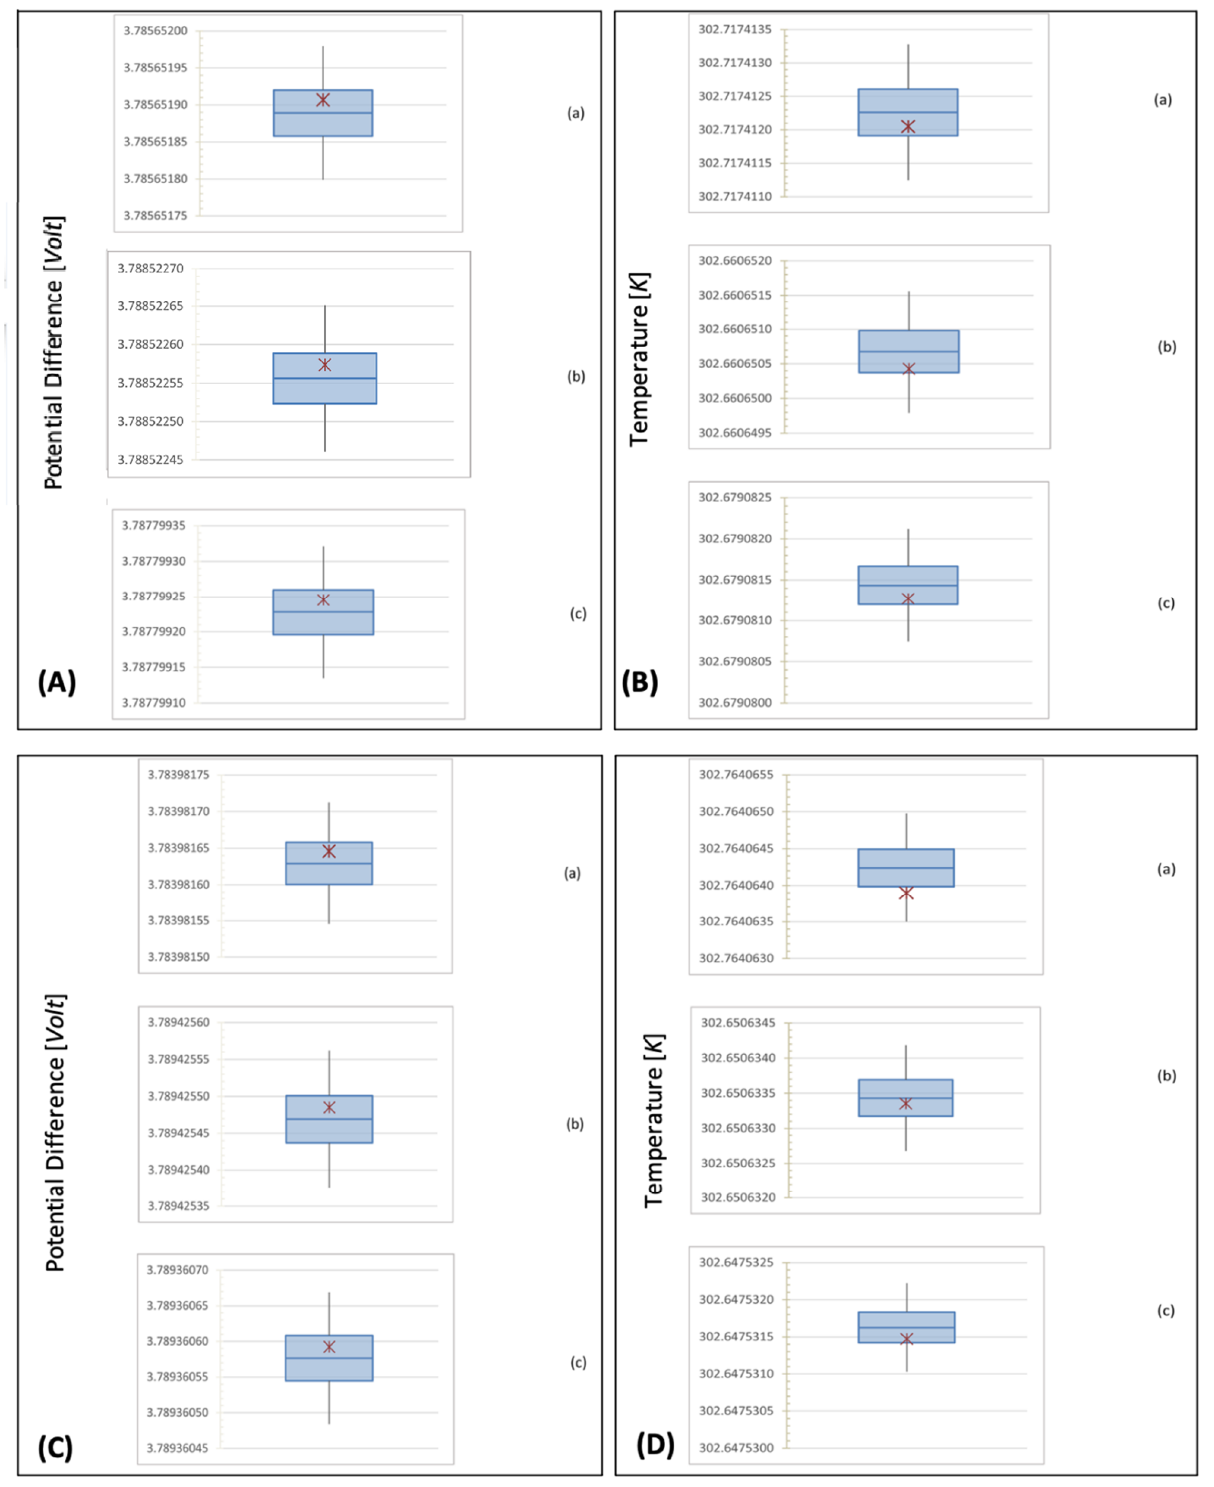
Figure 10. The box plots display the predicted probability distributions of ( A ) potential differences, ( B ) temperature, between plates at three random locations selected in block A in the second simulation group, and ( C ) potential differences, ( D ) temperature at the three locations in block B in the second simulation group. The red marks denote the corresponding results at these locations by the method in Guo’s work [16], and they all fall within the 95% prediction confidence interval presented in this paper. The scales are to show potential differences and temperatures as marked (Units: ( A , C ) Volt and ( B , D ) K).